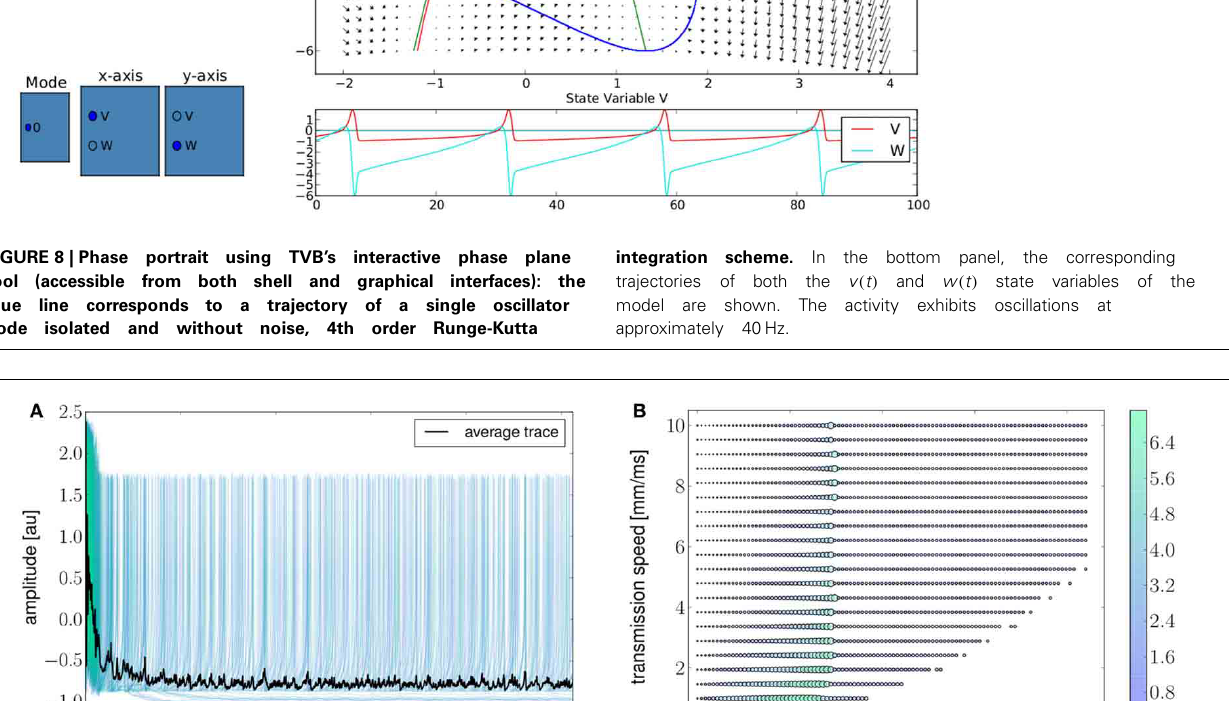
FIGURE 9 | (A) The activity of individual regions are illustrated in colored lines. The black line represents the average activity over the network nodes. Here brain regions are weakly coupled changing both the collective and local dynamics of the network. (B) Using TVB scientific library as a python module we can conveniently run thousands of simulations in parallel on a cluster. Note that TVB parallelizes different tasks e.g., simulations and analyses, taking advantage of multi-core systems, however, it does not parallelize the processes themselves. Simultaneous simulations allow for a systematic